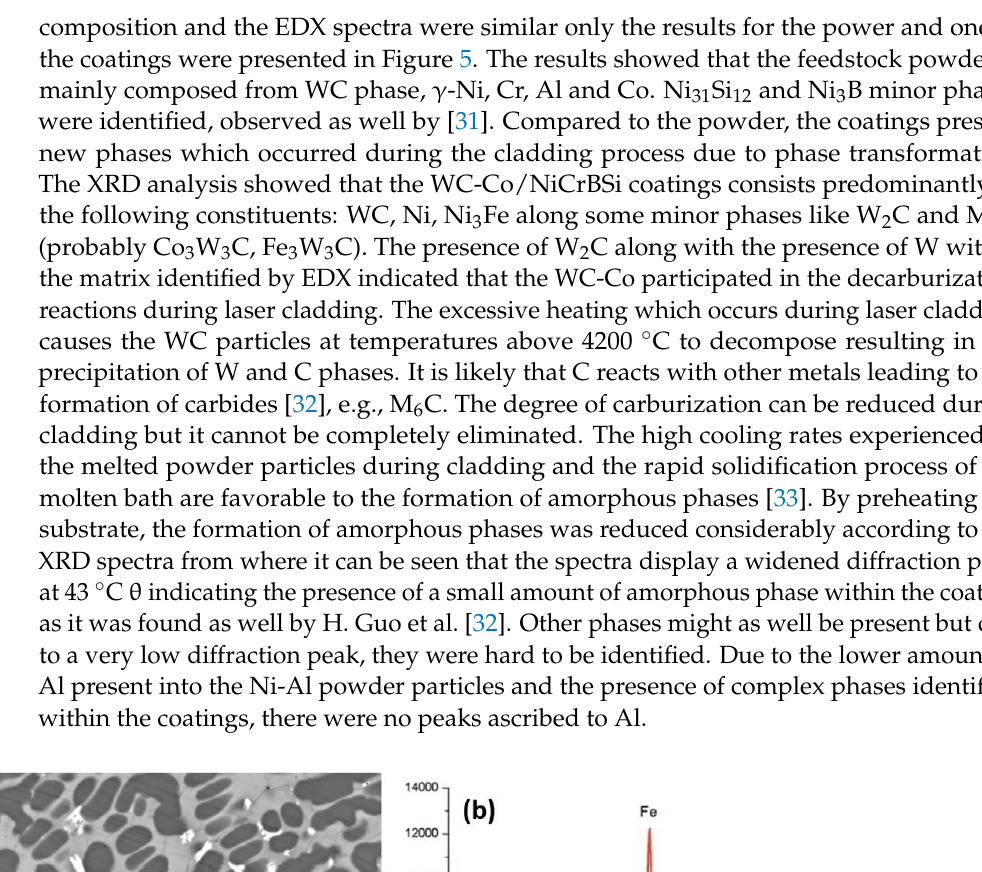
Figure 3. Back scattered electron micrographs of laser cladded WC-Co/NiCrBSi coatings indicating the morphology and thickness of coatings. Sample 1 (a), Sample 2 (b), Sample 3 (c), Sample 4 (d)and Sample 5 (e).